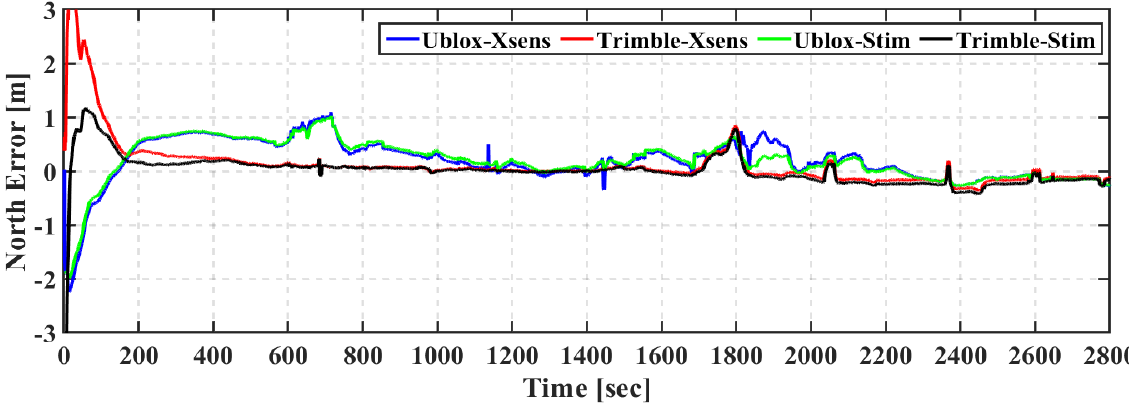
Figure 13. Second field trial: East positioning error of real-time TC GNSS PPP/INS for Ublox–Xsens, Trimble–Xsens, Ublox–Stim, and Trimble–Stim solutions.